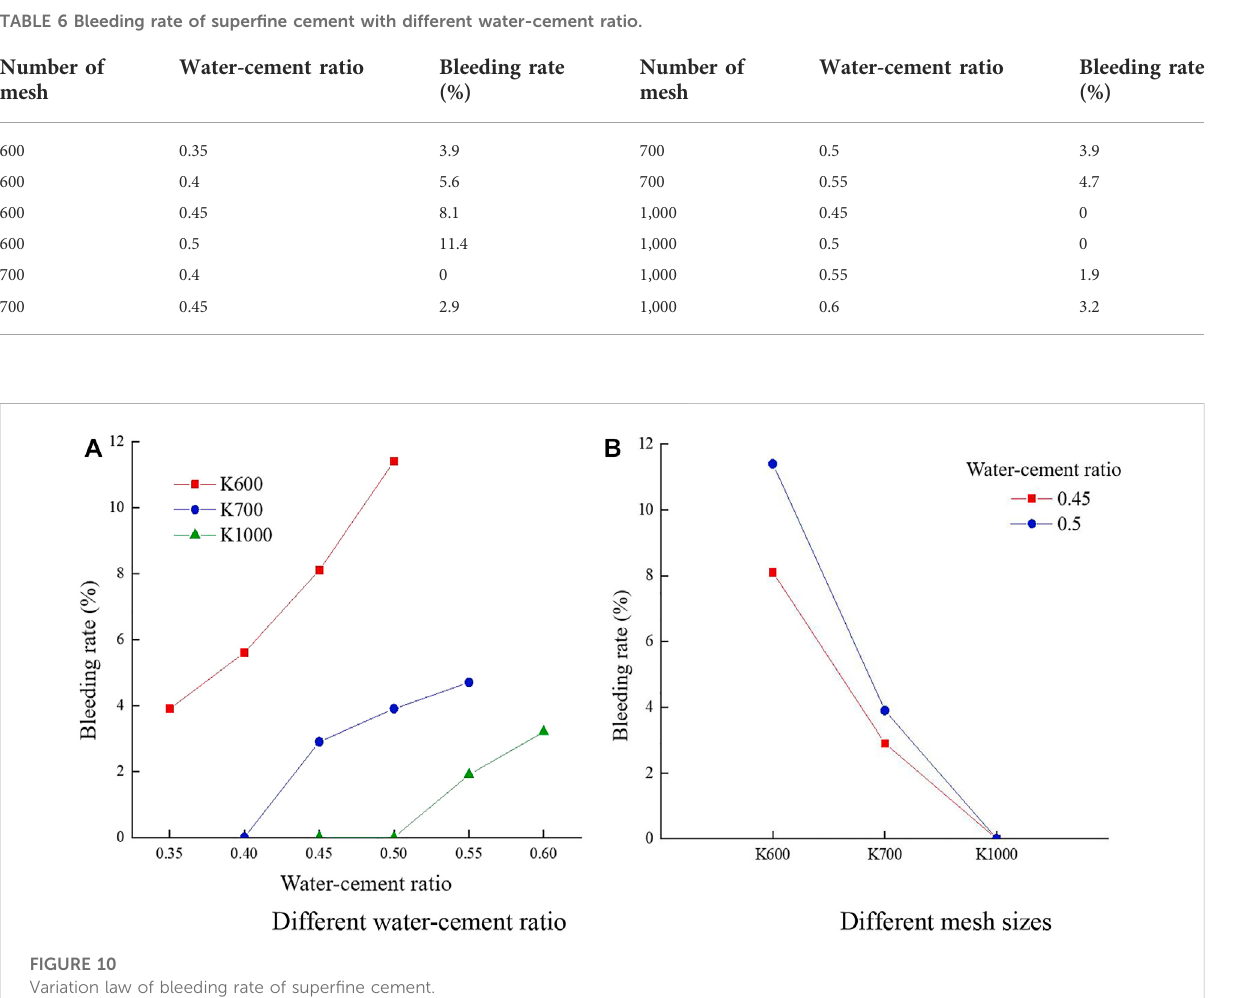
FIGURE 9 Stability experiment.